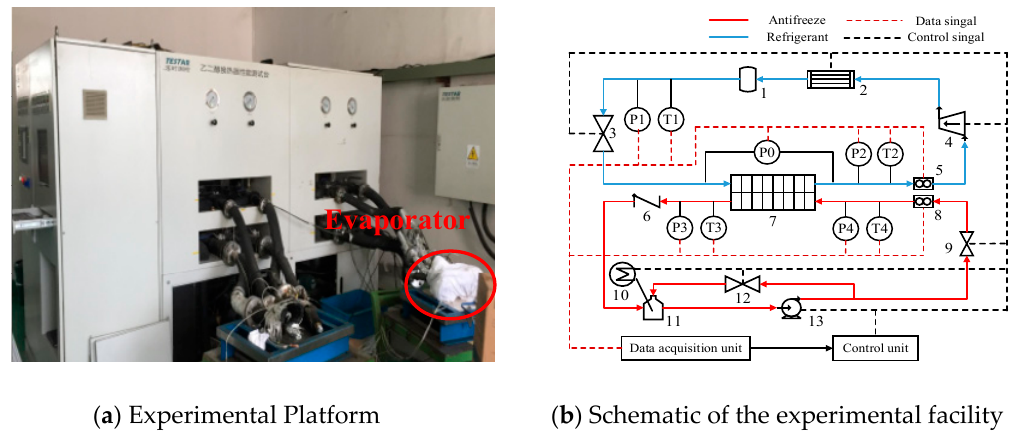
Figure 9. Experimental platform and its schematic of the experimental facility.